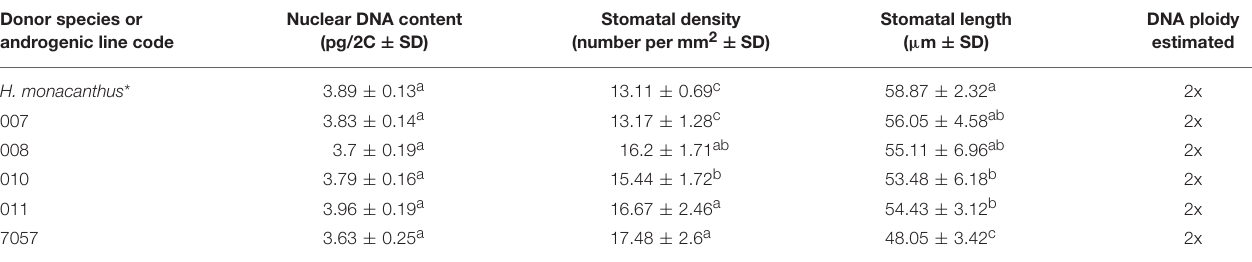
TABLE 1 | Nuclear DNA content, stomatal density and length, and DNA ploidy estimation in five H. monacanthus androgenic lines. Donor species or androgenic line